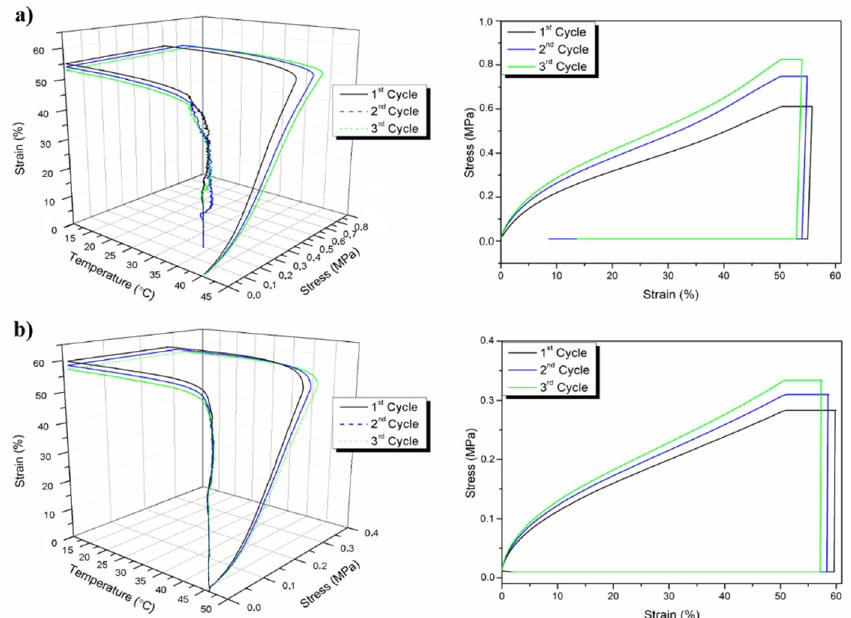
Figure 12. Thermo-mechanical shape-memory cycles of PLA-OLA (80:20) at ( a ) 40 ◦ C and ( b ) 45 ◦ C